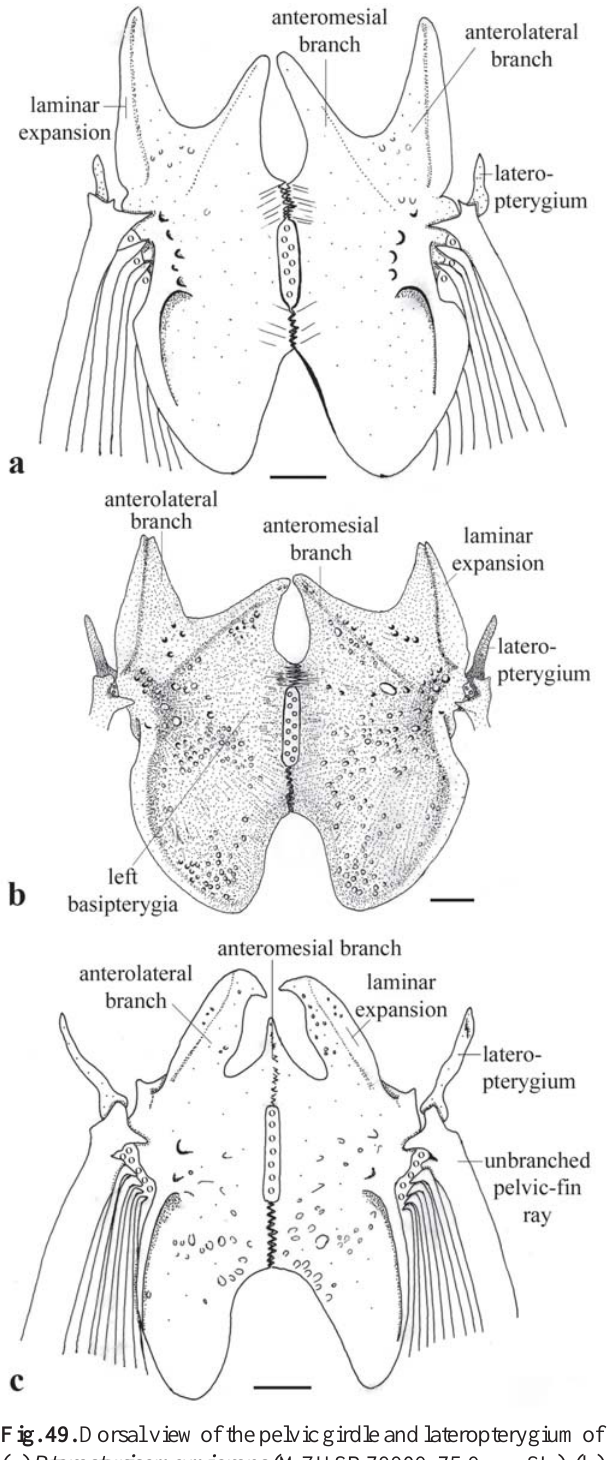
Fig. 49. Dorsal view of the pelvic girdle and lateropterygium of (a) Pterosturisoma microps (MZUSP 79909, 75.9 mm SL), (b) Lamontichthys stibaros (FMNH 84111, 62.4 mm SL), and (c) Neoplecostomus ribeirensis (MZUSP 100920, 45.3 mm SL). Scale bar = 1